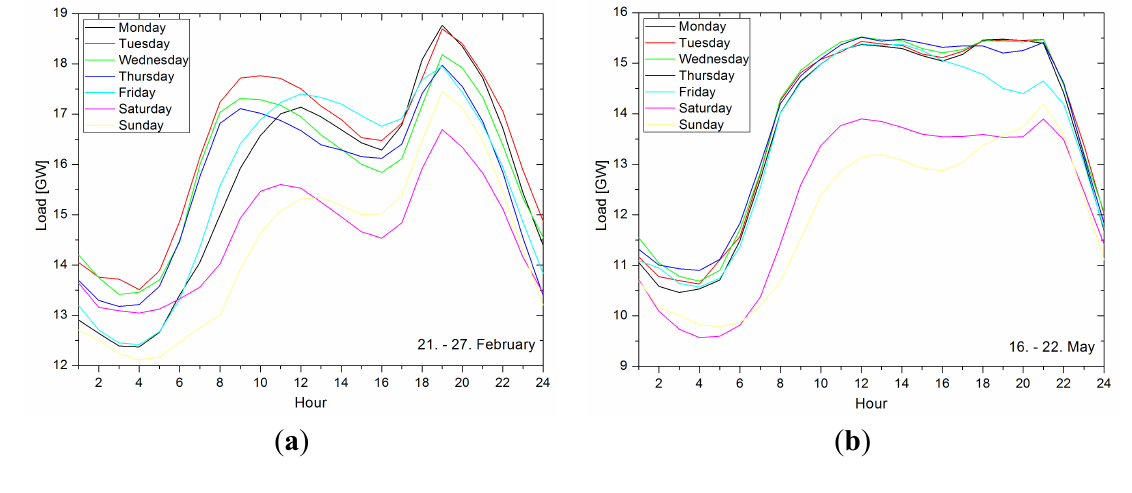
Figure 3. Hourly load during the day. ( a ) February 21–27; ( b ) May 16–22; ( c ) August 16–22; ( d ) November